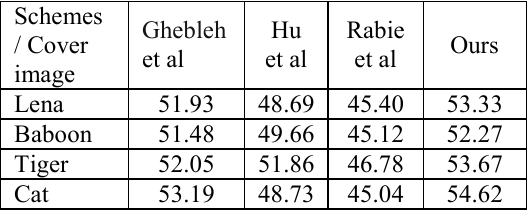
Table 3 . Comparison of PSNR values of